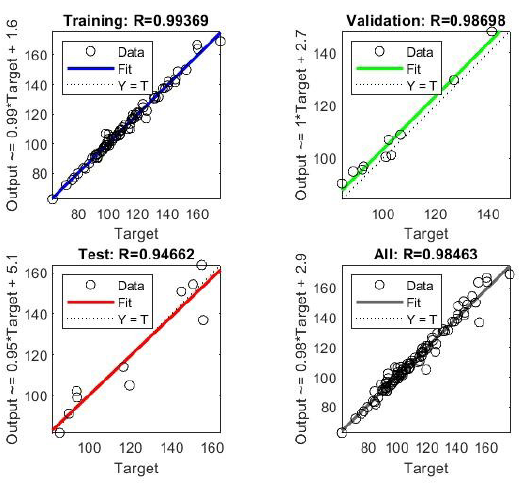
Figure 11. Regression analysis with training, testing, validation and all data sets.